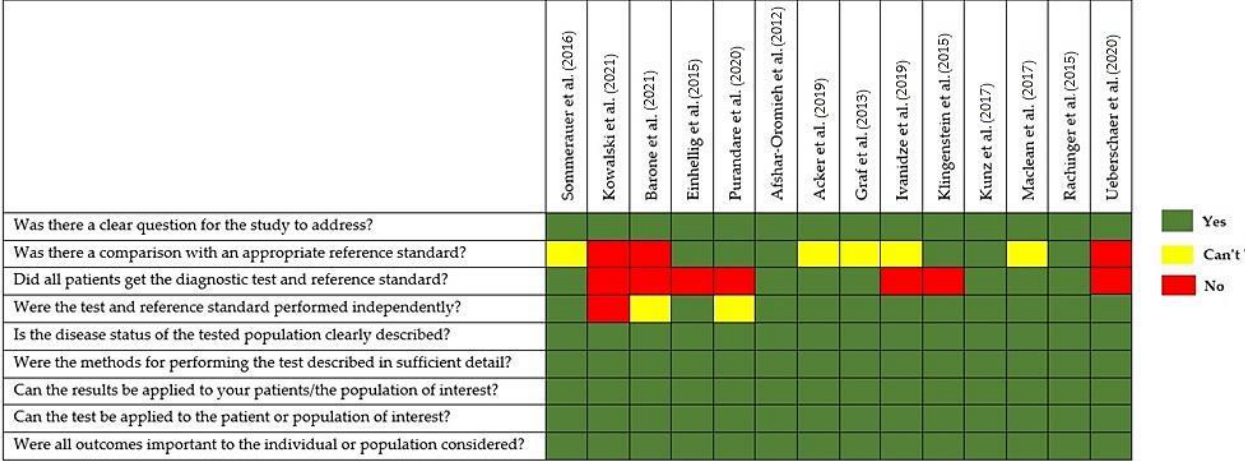
Figure 3. Quality appraisal of selected articles using CASP checklist for diagnostic test studies [22 – 35].